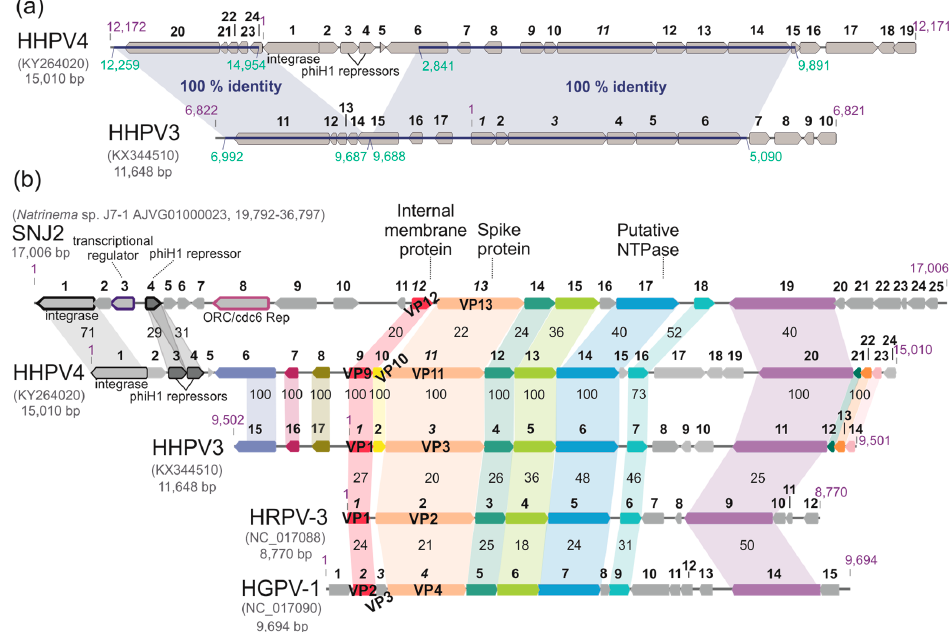
Figure 5. Comparison of genomes of betapleolipoviruses. All genomes are circular double stranded (ds) DNA molecules, which are shown as linearized molecules. Open reading frames (ORFs) or genes are represented as grey arrows and are numbered (gene numbers are italicized). GenBank accession numbers are indicated in brackets, and the total length of genome sequences is marked under virus name. Nucleotide coordinates are shown in purple. ( a ) Comparison of HHPV4 and HHPV3 genomes. The regions of 100% nucleotide identity are marked with blue, and nucleotide coordinates of the identical regions are shown in dark green; ( b ) All known betapleolipovirus genomes are compared. Virion proteins (VPs) are marked. Similar ORFs or genes are in the same colours. Amino acid identities (%) between (putative) proteins are shown in between the genomes. HRPV-3, Halorubrum pleomorphic virus 3; HGPV-1, Halogeometricum pleomorphic virus 1.